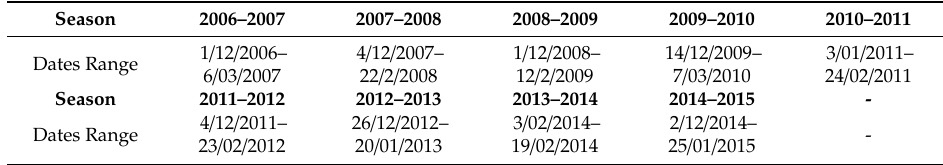
Table 3. Range of dates with in-situ di ff use and global radiation from the AWS at